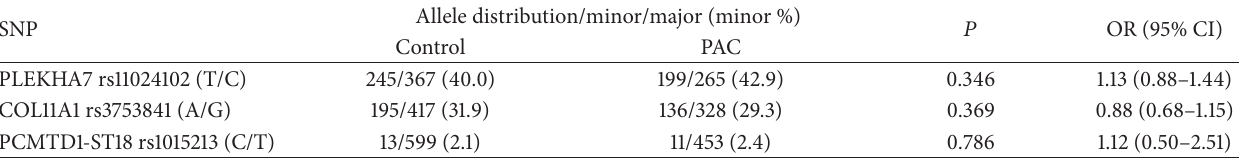
Table 3: Allele frequency of SNPs in control and PAC